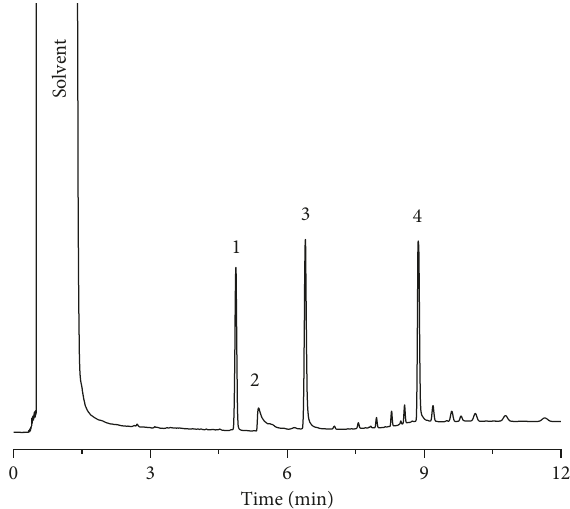
Figure 6: Separation of pesticide residues extracted from the caj´a- manga pulp by the SLE-LTP method, using gas chromatography with flame ionization detection. Conditions: capillary column 30m × 0.32mm i.d. × 0.25 µ m film thickness, 5% phenylmethylsiloxane- 95% dimethylsiloxane, split injection 1:5, injected volume 1 µ L, injector temperature 280 ° C, FID temperature 300 ° C, N 2 flow rate bendazole; (3) carboxin; (4)